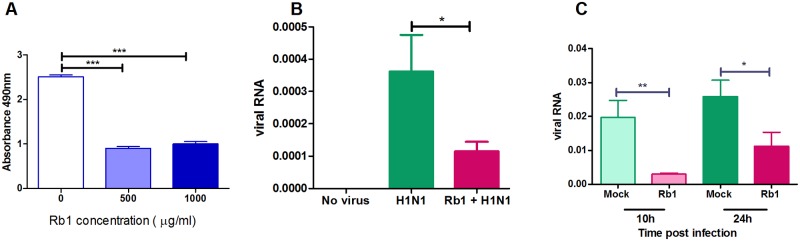
Rb1 prevents the attachment of virus with α2–3 sialic acid receptors on host cell surface.The attachment of Rb1 treated and untreated A/Nanchang/8002/2009 (H1N1) virus to α2–3’ sialic acid receptors was performed (A) by using alpha N-acetyl neuaminosyl-2-3’-beta D-sialylgalactose in oligosaccharide binding assay (B) by infecting CHO cells that predominantly contain α2–3’ sialic acid receptors at 4°C. The virus showed significantly less binding affinity in the presence of 500μg of Rb1 compared to mock control. (C) In replication assay, CHO cells were infected with Rb1 treated or untreated A/Nanchang/8002/2009 (H1N1) virus 37°C for 10 and 24 hours and subjected to real time RT-PCR. Rb1 treatment significantly inhibited 2009pdm H1N1 infection. *** P < 0.0005, ** P < 0.005, *P < 0.05.